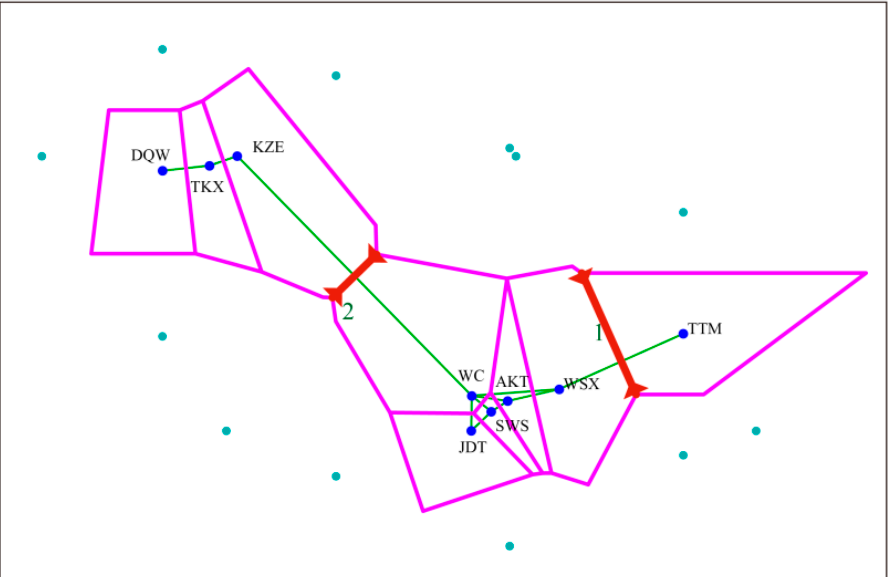
Figure 4. The two genetic boundaries (red bold lines) detected by BARRIER version 2.2 using genetic distance ( N m). Pink lines and solid green lines represent the Voronoi tessellation and the Delaunay triangulation, respectively. Table 3. Pairwise F ST among nine populations of T. yarkandensis.